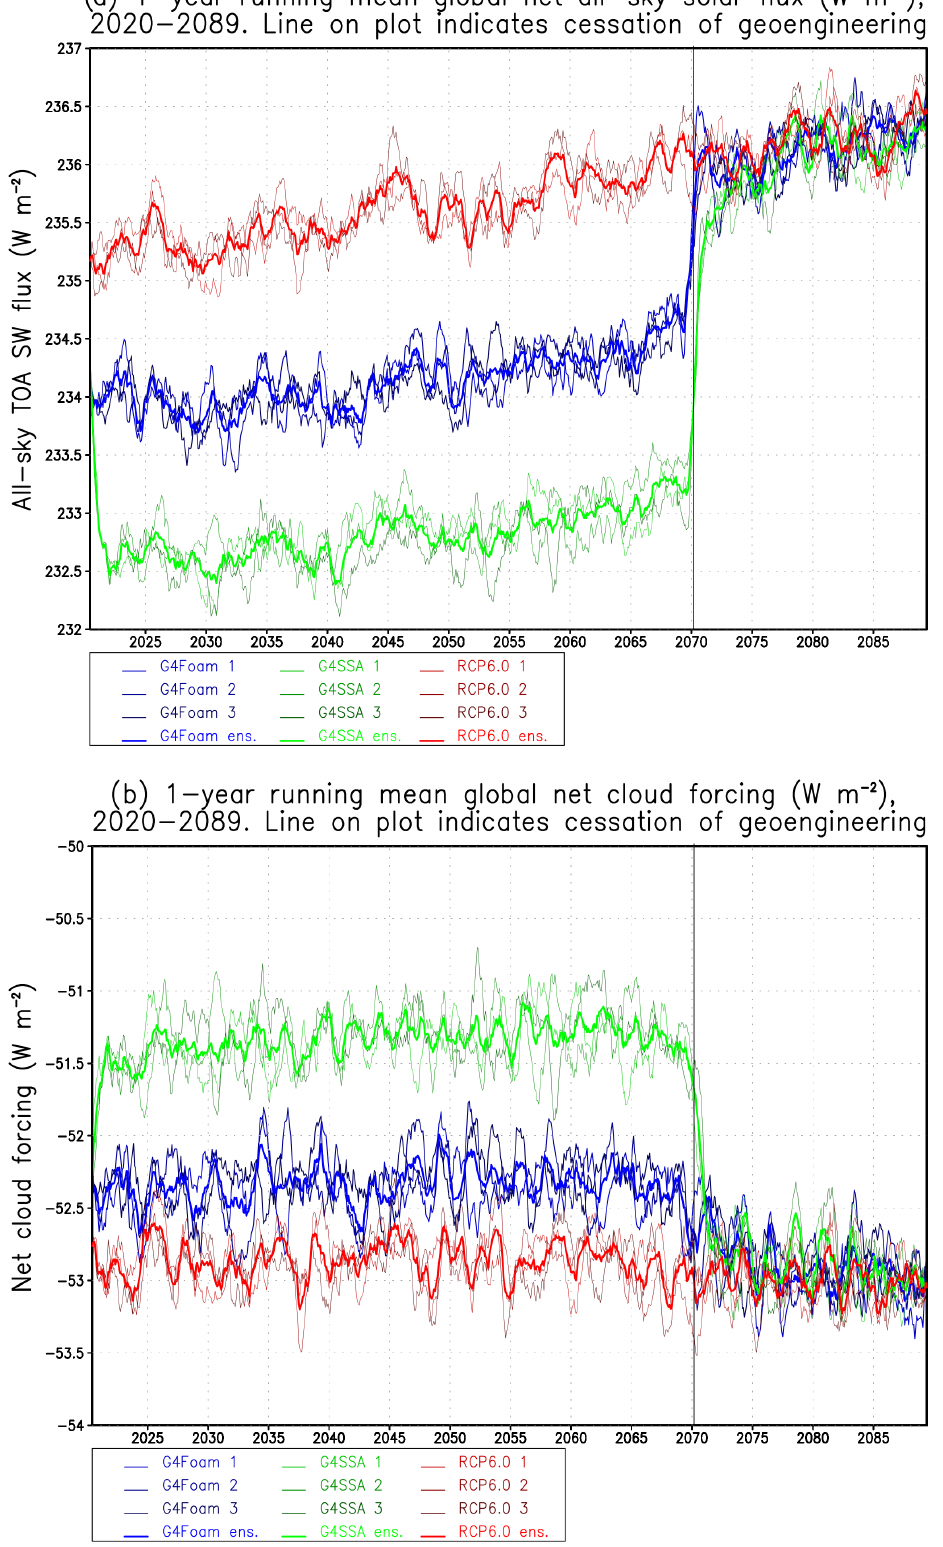
Figure 2. (a) Net all-sky SW flux at top of atmosphere and (b) time series of global mean net cloud forcing. Each ensemble member and the ensemble mean are shown for each